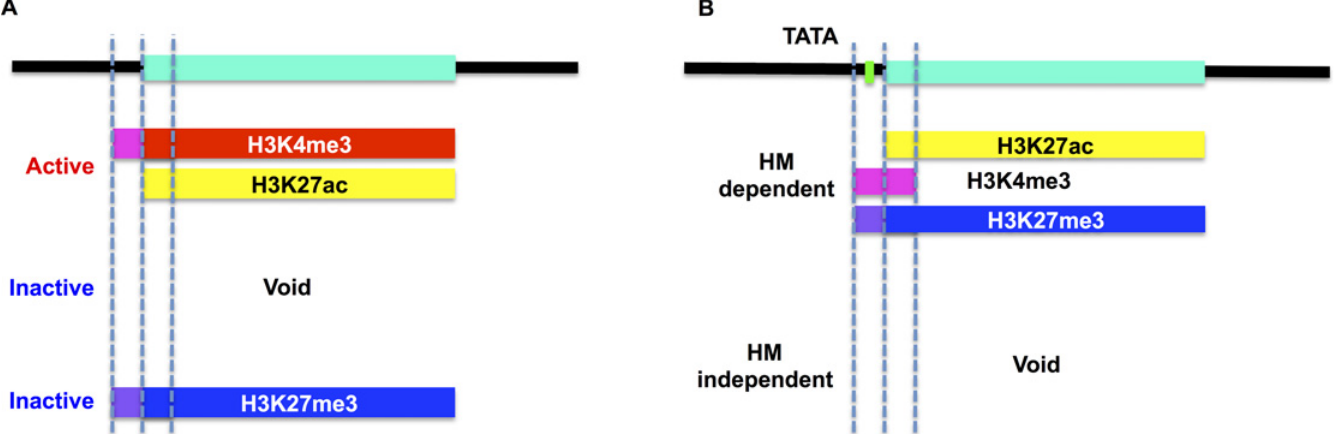
Fig 6. Hypothetical model of the function of the TATA box. The green bar represents the transcribed region, and the dotted lines represent the 5 0 terminal of the core promoter, +1 position (TSS), and 3 0 terminal of the core promoter, from left to right. (A) Model of TATA-less core promoters. TATA-less core promoters exhibit reduced temporal changes during development and could be grouped into three types: core promoters with continuous active marks, those with occasional histone modifications (void), and those with continuous inactive marks. Because core promoters of the first type do not have inactive marks, their RNA expression values can be predicted by the status of the active marks alone. (B) Model of TATA-containing core promoters. TATA-containing core promoters exhibit increased temporal changes during development and could be grouped into two types: core promoters whose RNA expression values are dependent on the status of histone modifications, and core promoters whose RNA expression values are uniform, despite the void state of histone modifications. Since core promoters of the first type have both of active and inactive marks, all of the histone modification statuses are informative for prediction of their RNA expression